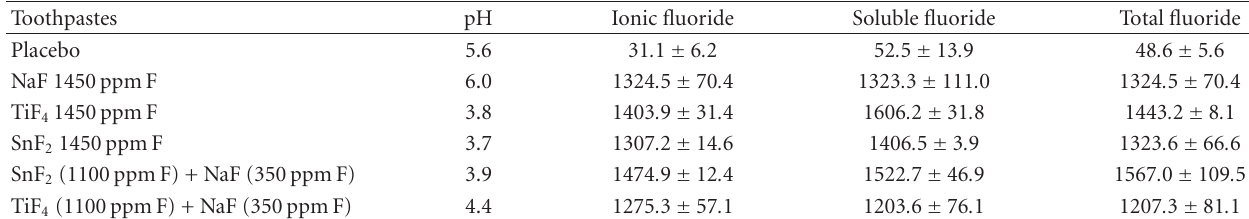
Table 1: Mean ( ± sd) of fluoride concentration (ppm or µ g/g) and pH of the experimental